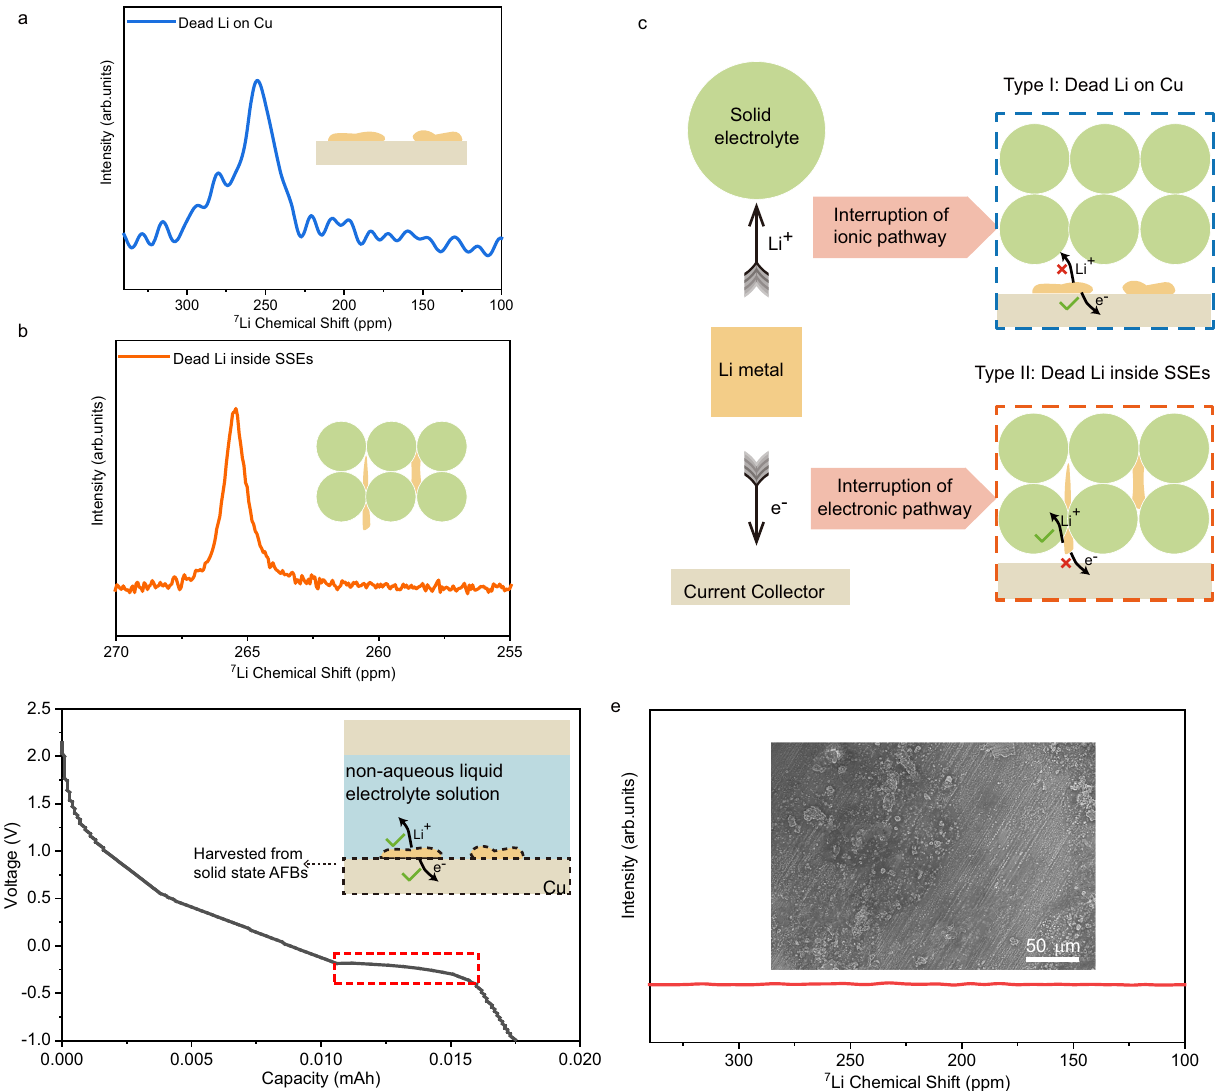
Fig. 5 | Formation modes of dead Li in the SSBs. a 7 Li NMR spectrum of the recovered Cu disc containing dead Li, performed under static conditions (ex situ, with LPSCl). b 7 Li NMR spectrum of SSEs recovered from cycled AFBs, performed under ex situ MAS conditions, MAS speed: 12kHz (with LPSCl). c Schematic of the two formation modes of dead Li in SSBs: dead Li on Cu and dead Li inside SSEs. d Initial voltage curve of a coin cell tested at 0.05mAcm − 2 and assembled using a deadLicontainingCuelectrode(harvestedfromanall-solid-stateAFBswithLPSCl),